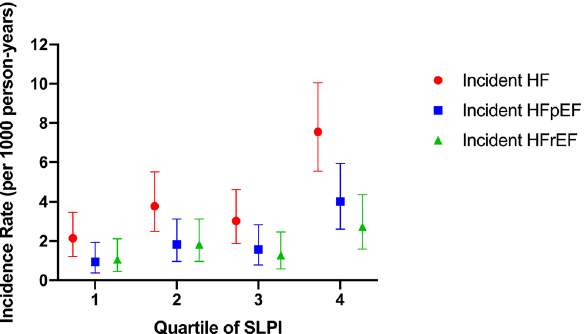
Figure 1. Incidence rates for heart failure (including subtypes) by quartile of serum SLPI. Unadjusted incidence rates for total heart failure (HF), HF with preserved ejection fraction (HFpEF), and HF with reduced ejection fraction (HFrEF). Error bars represent 95% confidence interval (CI).